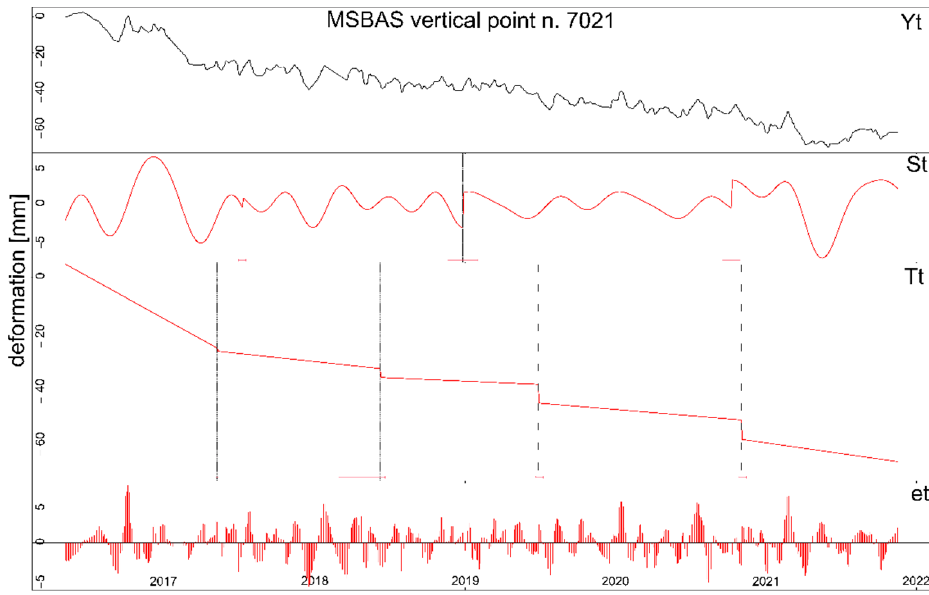
Figure 7. BFAST applied to the vertical component of the MSBAS point n. 7021 showing the original time series (Yt), decomposed in seasonal (St), trend (Tt), and error (et) component.